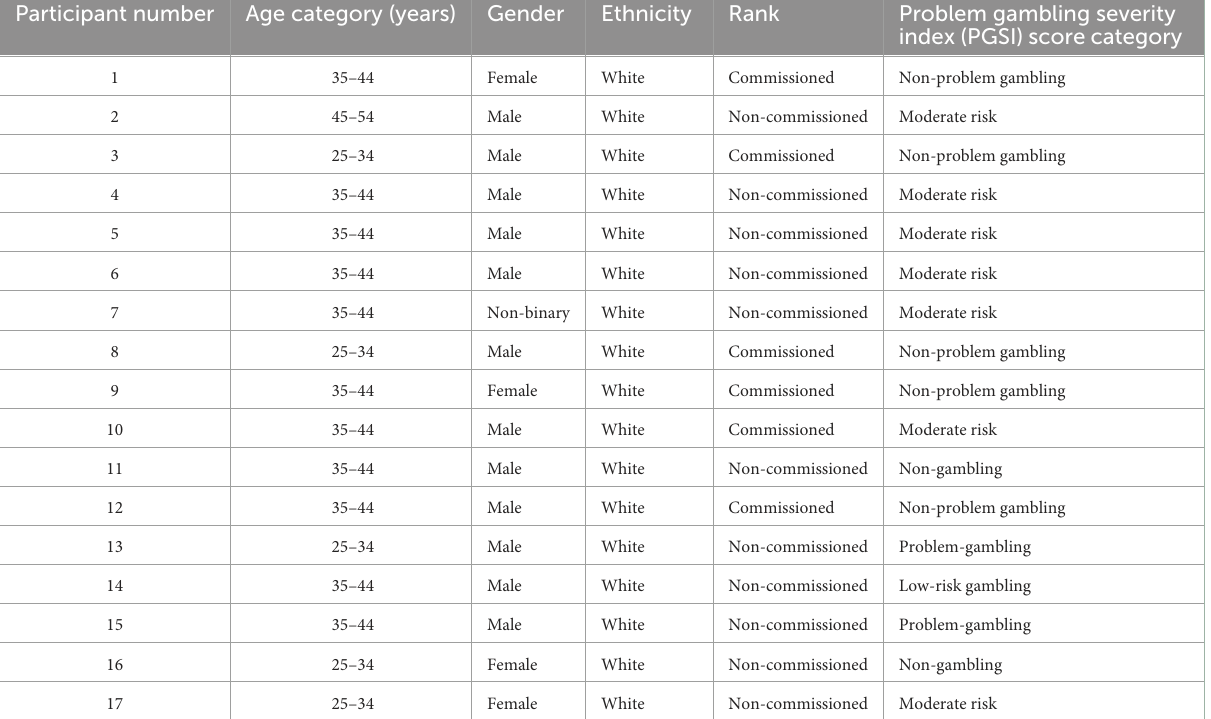
TABLE 1 Participant information. Participant